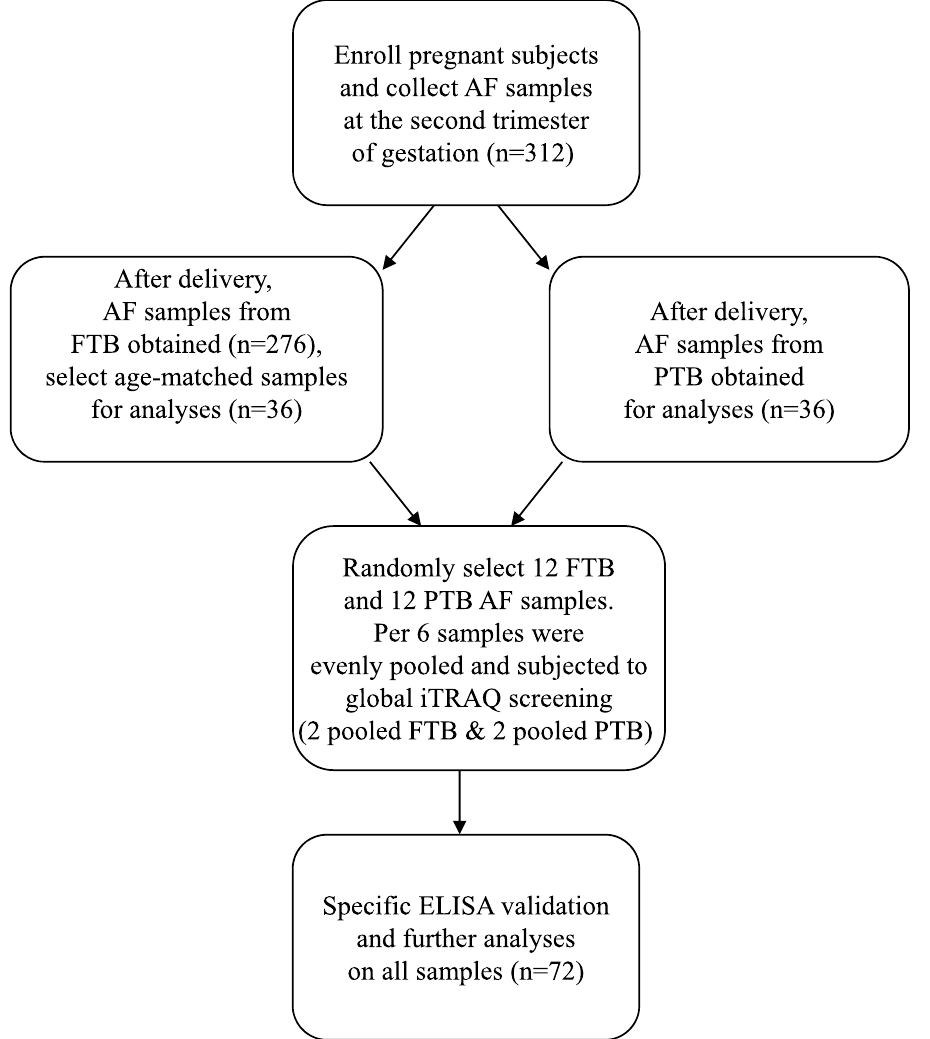
Figure 1. The overall flowchart of this study. We used a flowchart to illustrate the overall workflow and to direct the numbers of samples size, collected and